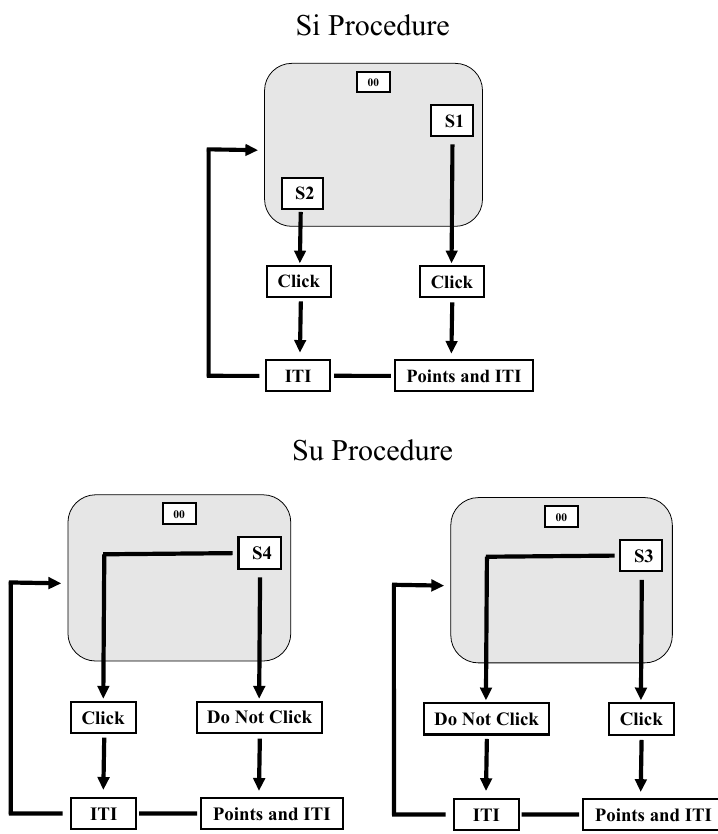
Figure 2 . Schematic illustration of the contingencies in the Si and Su